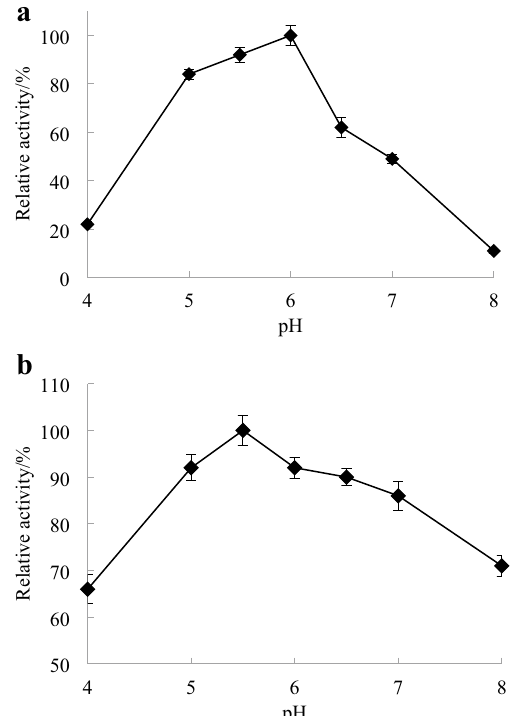
Figure 6. Effect of pH on the activity ( a ) and stability ( b ) of CapA.